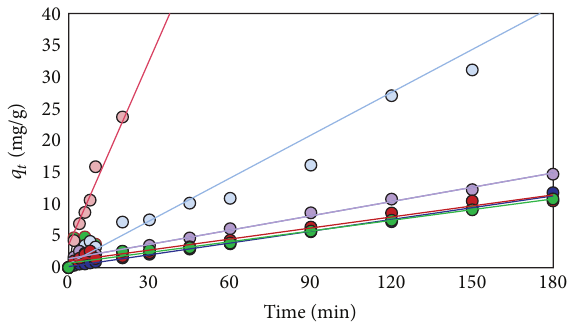
Figure 10: Plot of 𝑡/𝑞 𝑡 of Cd 2+ versus time for effect of different kindsofvariousadsorbents(RS(lightblue),RS-oil3hr(purple),RS- NaOH 450 W (blue), Bagasse (pink), Bagasse-NaOH 600 W (red), and Dowax (green)).